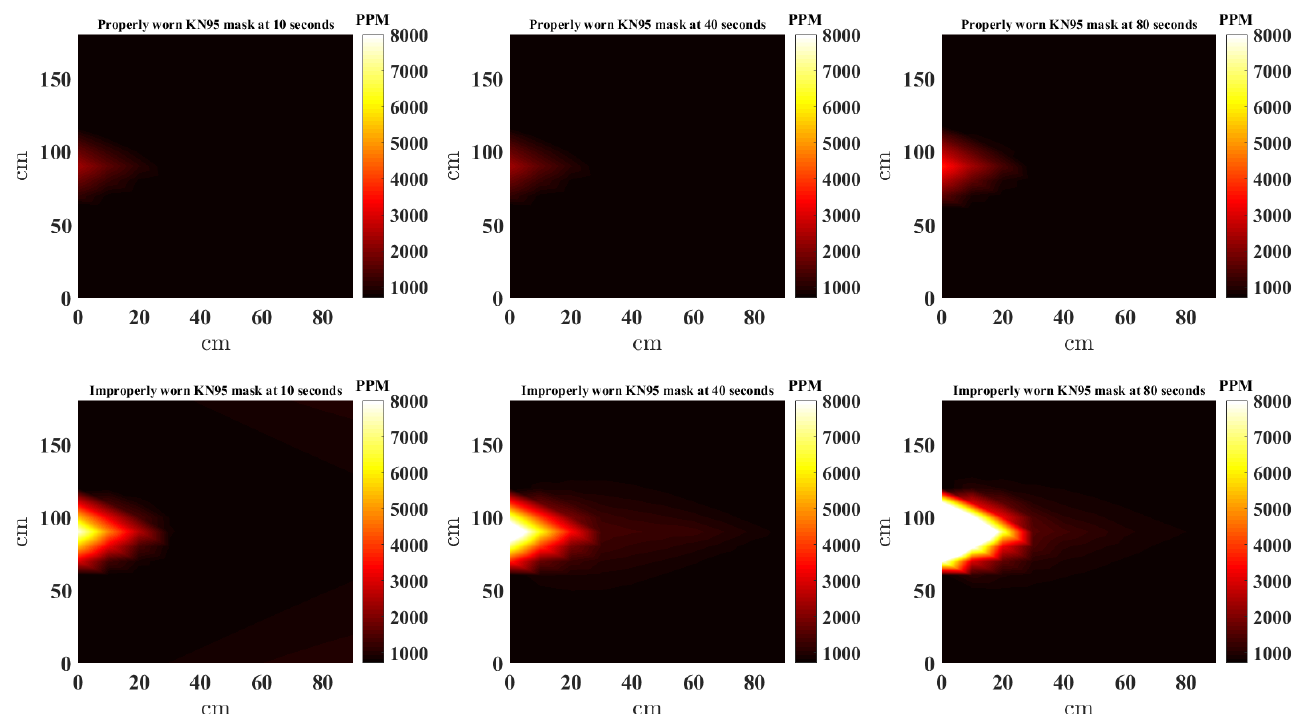
Figure 11. Interpolated CO 2 with properly and improperly worn KN95